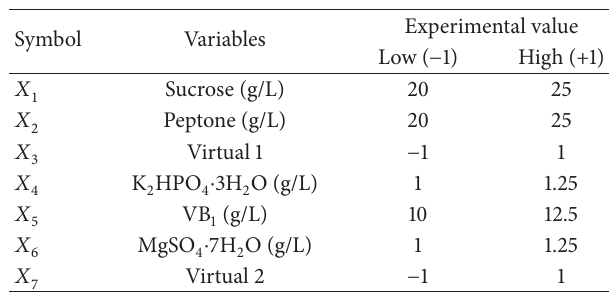
Table 1: Range of different factors investigated with Plackett- Burman design.